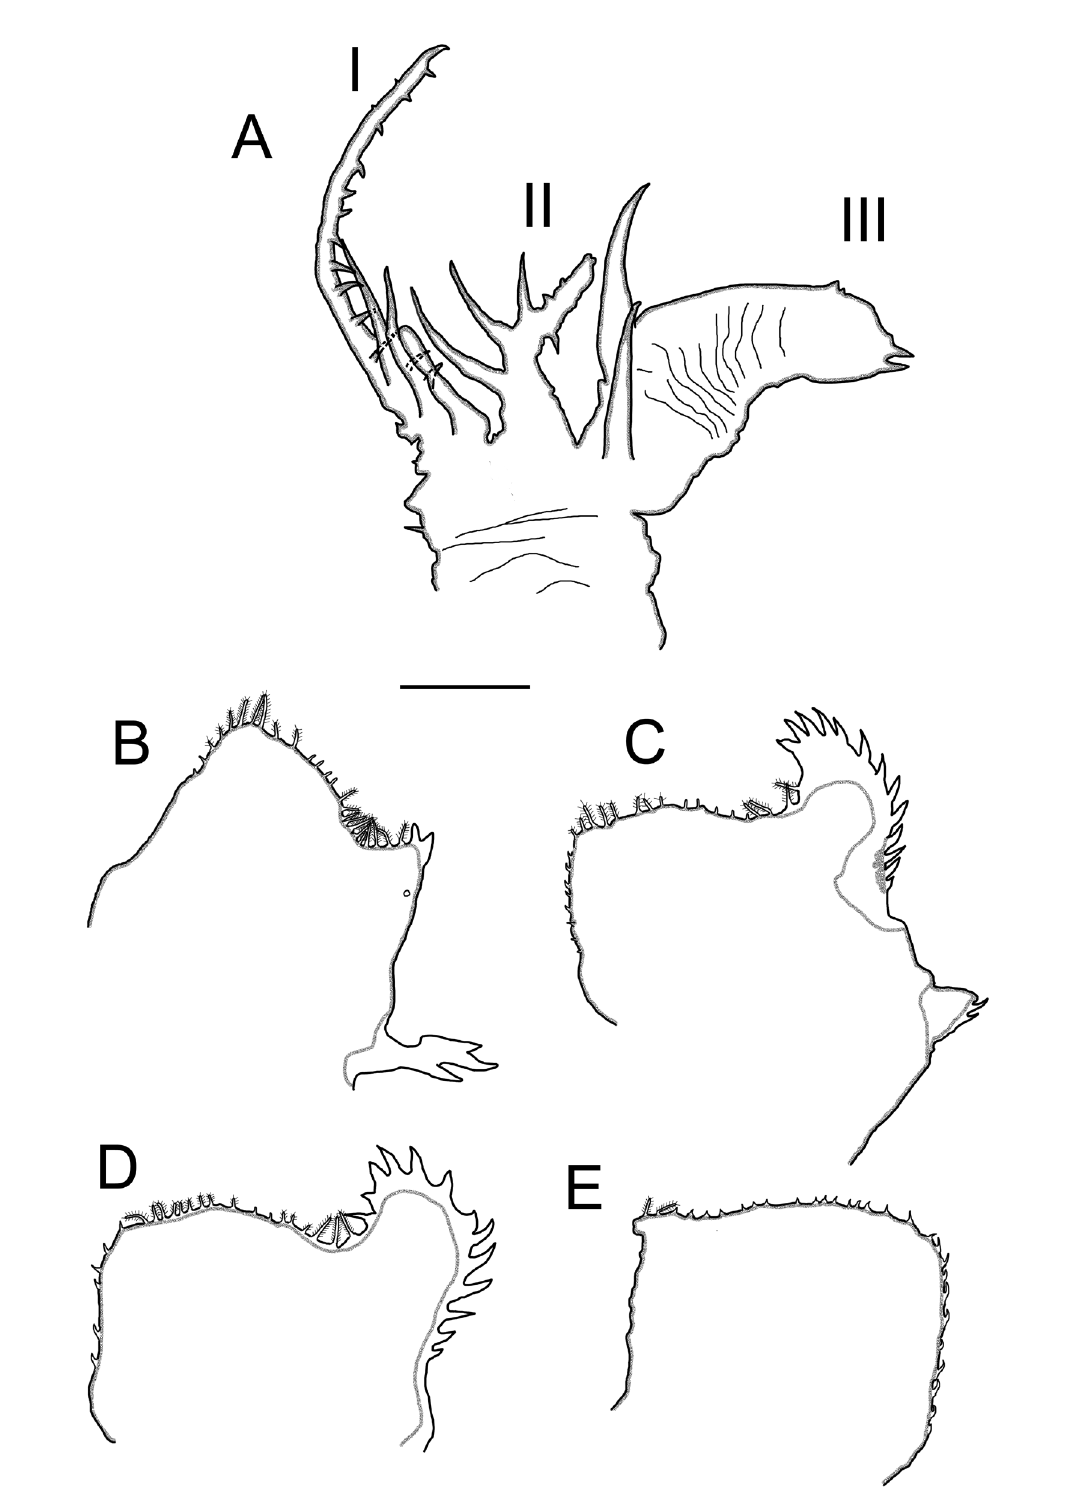
Fig. 3. Dendrocephalus aranai Rabet & Lacau sp. nov., ♂. A . Branch 2D of the frontal appendage. B . Endopodite of the first limb. C . Endopodite of the second limb. D . Endopodite of the third limb. E . Endopodite of the fourth limb. Scale bar: 0.5